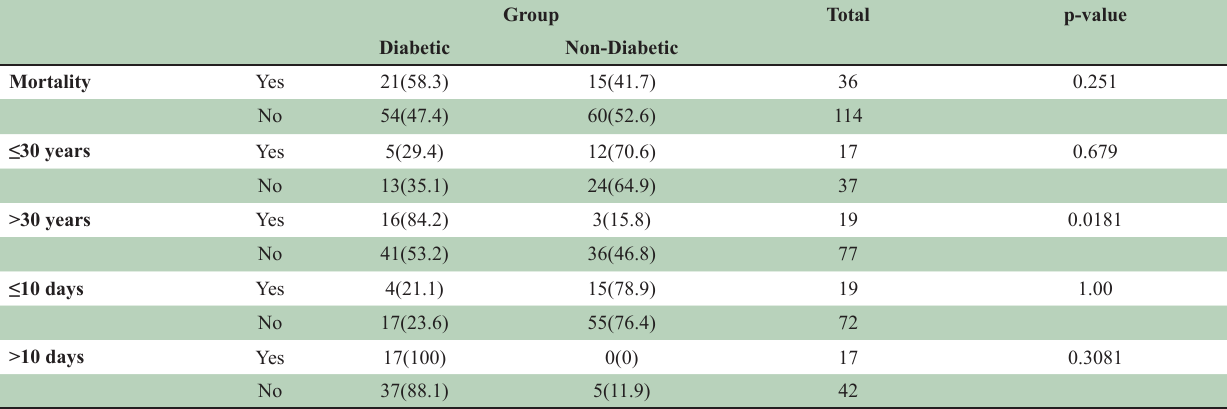
** Highly Table–III: Association between mortality, age, hospital stay duration and study groups(n=150).